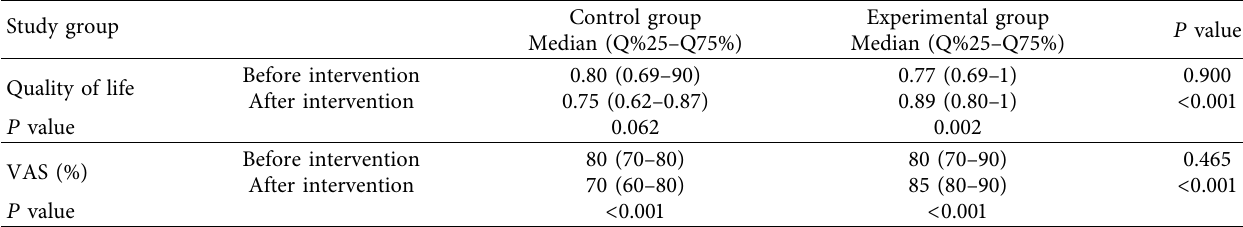
Table 3: Comparison of the mean score of quality of life and self-assessment of health before and after the intervention in the studied patients.